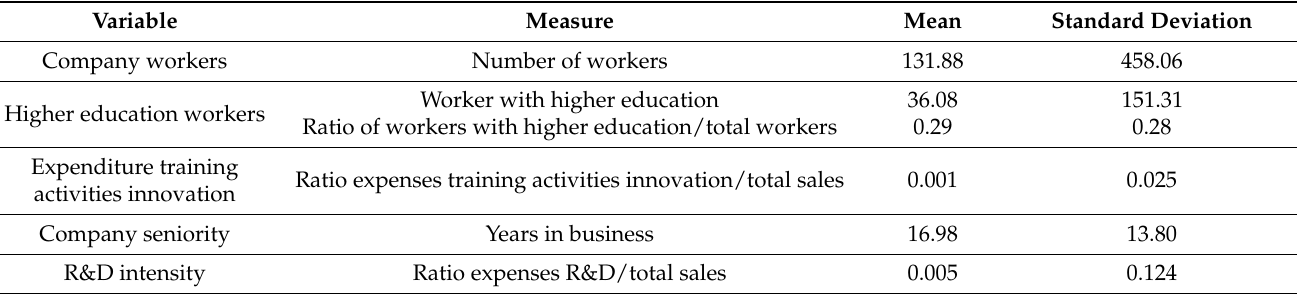
Table 6. Descriptive